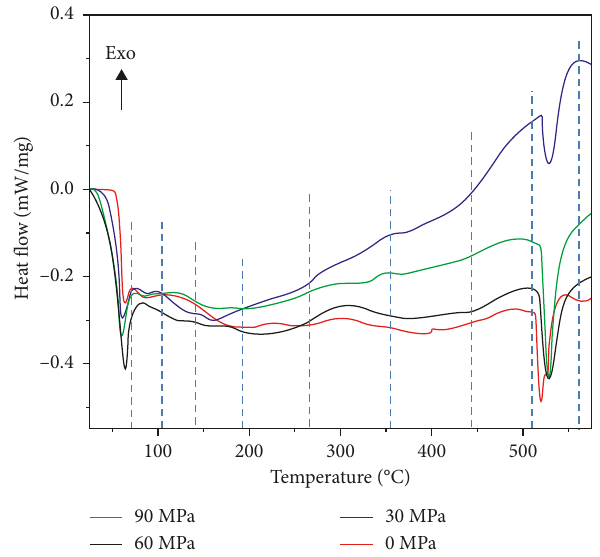
Figure 2: DSC analysis of squeeze cast specimens at different specific